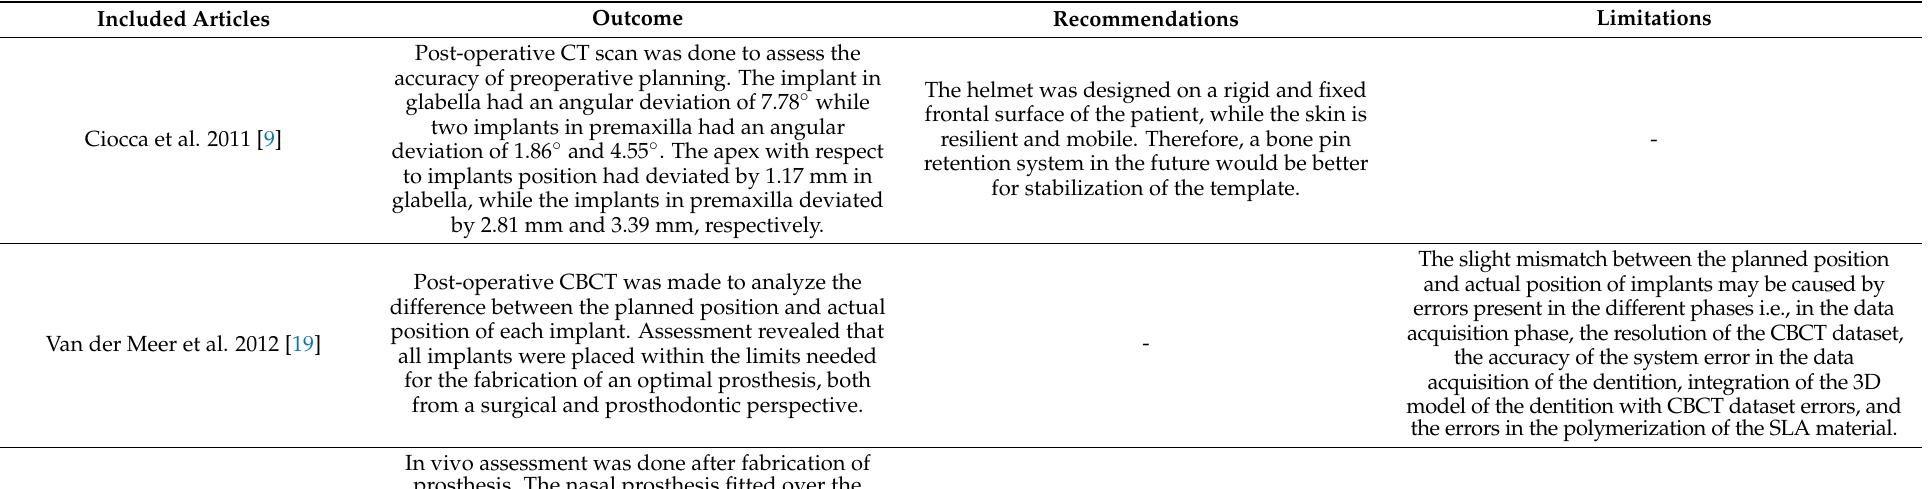
Table 4. Enlisted are the clinical outcomes, recommendation, and limitations of procedures mentioned in included